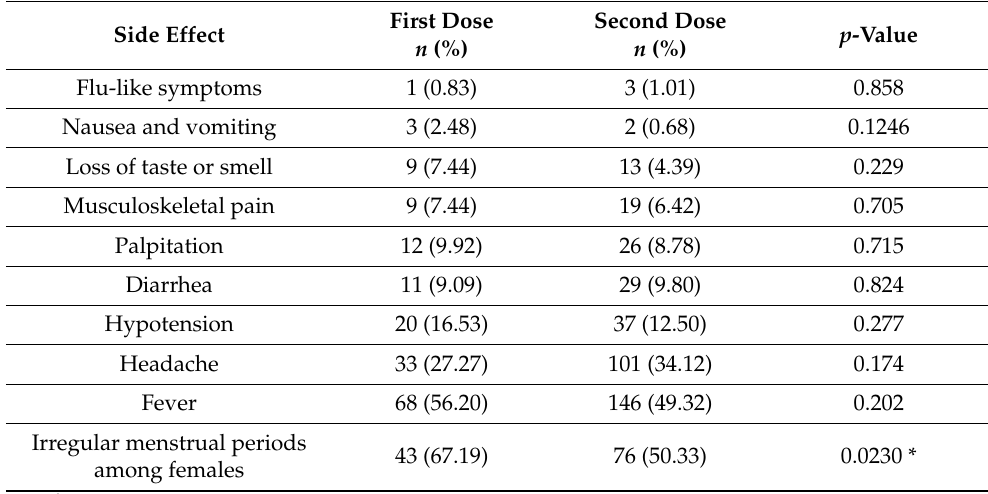
Figure 1. Rates of commonly reported side effects of COVID-19 vaccines. Table 2. The frequency of commonly reported COVID-19 vaccine side effects based on the number of